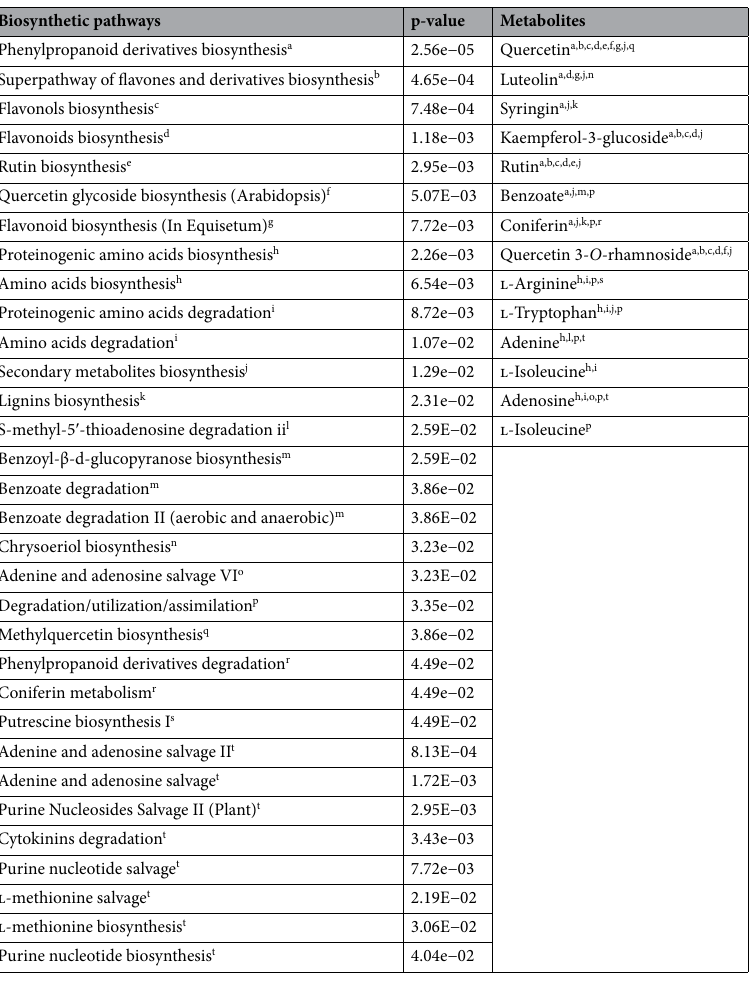
Table 1. Summary of highly correlated metabolites in different biosynthetic pathways. Letter(s) after the pathways and metabolites indicate the involved metabolites in the same pathway. Enrichment analysis was carried out using the Fisher Exact statistical